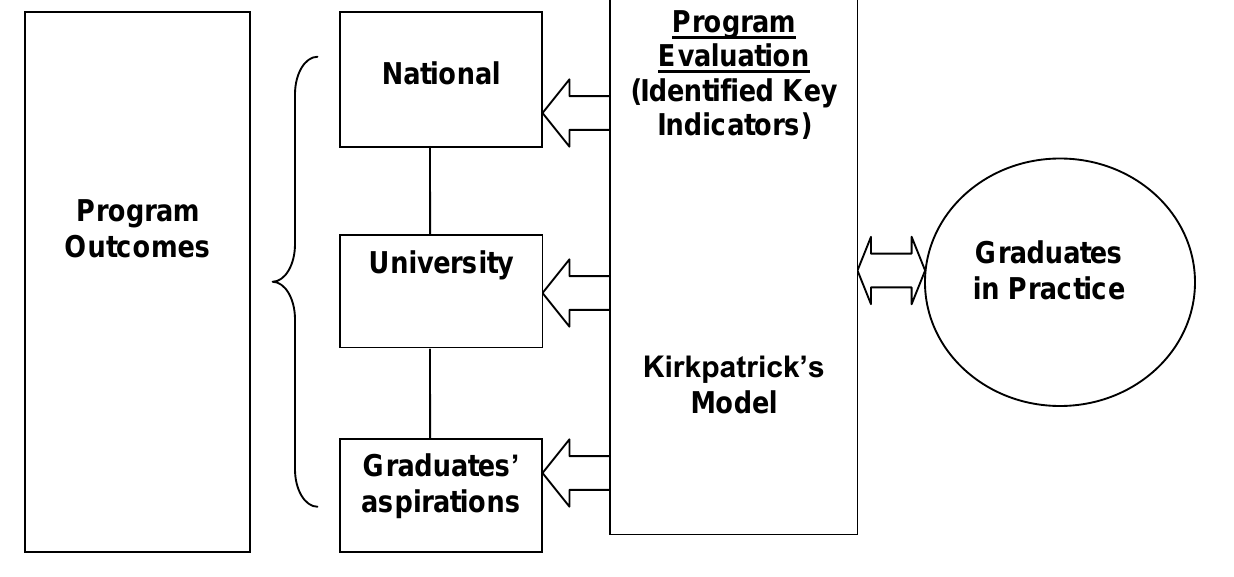
Figure 1 . Understanding the relationship between program, program outcomes, and program